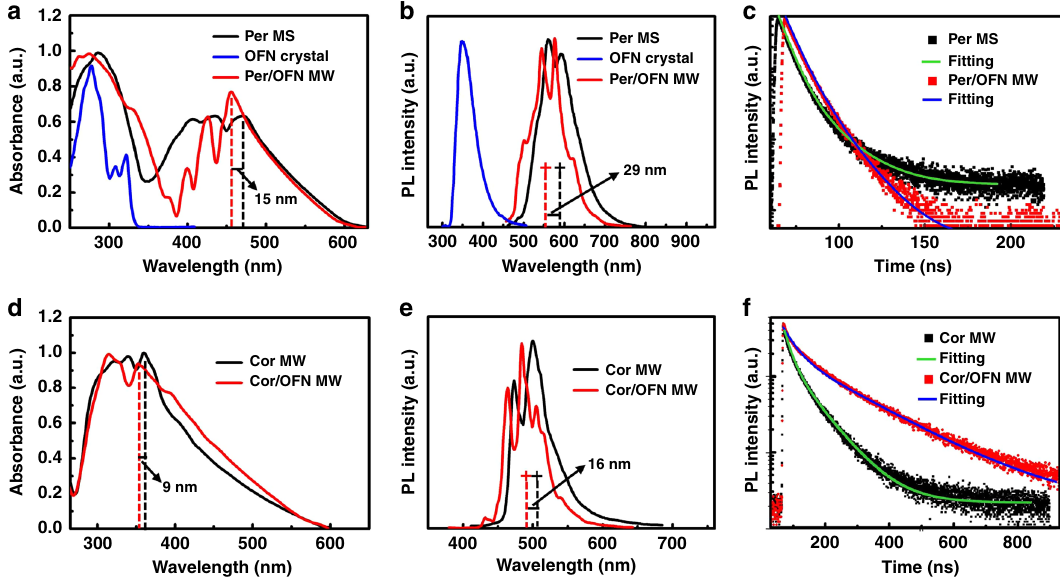
Fig. 3 Photophysical properties of the microcrystals in solid states. ( a ) Absorption spectra, ( b ) PL spectra and ( c ) Time-resolved PL measurements of Per MS and Per/OFN MW under the excitation of 460 nm. ( d ) Absorption spectra, ( e ) PL spectra and ( f ) Time-resolved PL measurements of Cor MW and Cor/OFN MW under the excitation of 360 nm. All the curves were normalized to make the maximum intensities to be a same value for the purpose to compare their peak